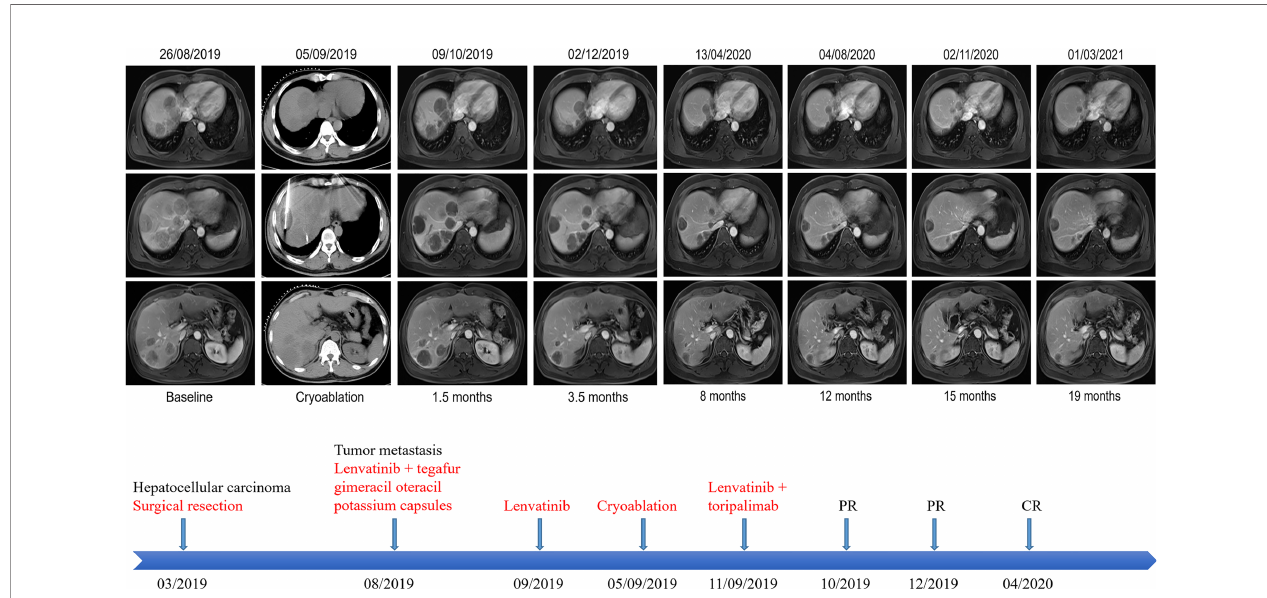
FIGURE 2 | Representative upper abdominal imaging showing changes in the liver tumor throughout the treatment period and the patient ’ s course of treatment. After intratumoral cryoablation combined with antiangiogenic therapy plus immune checkpoint inhibitors, the patient ’ s liver tumor was necrotic, with no obvious tumor activity, and some tumor lesions disappeared and shrank, which were evaluated as a complete response according to